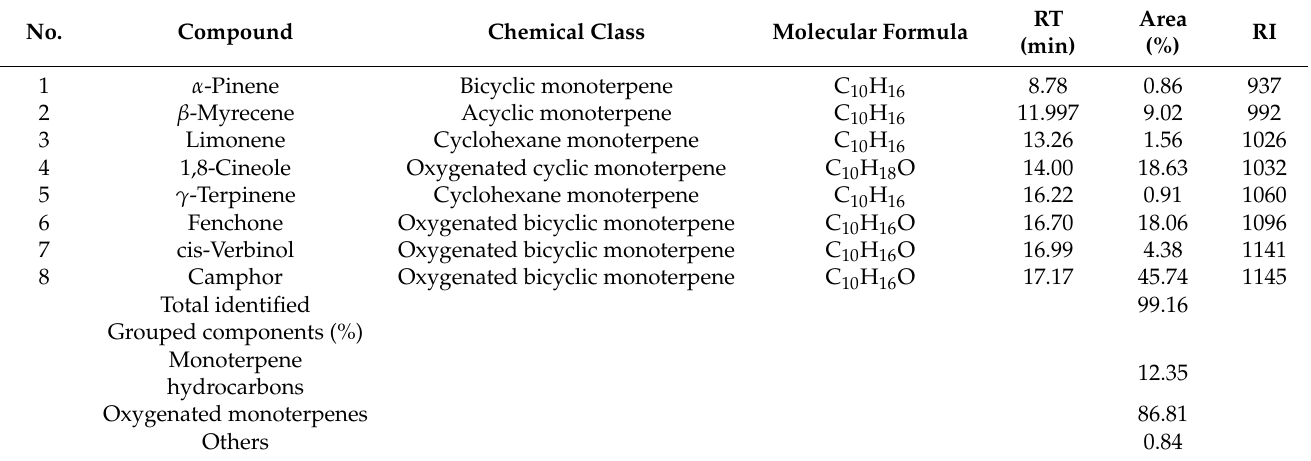
Table 1. Chemical constituents identified from the essential oil of Lavandula dentata .